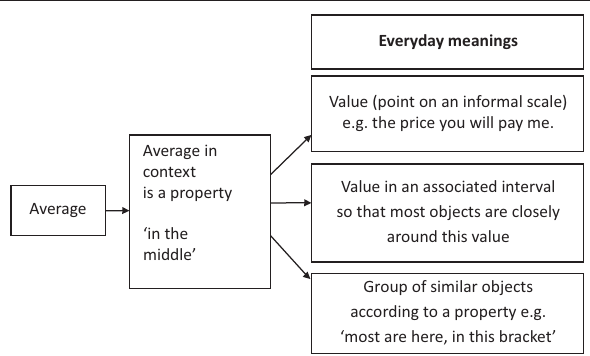
FIGURE 2: Three narratives about the mean as the average in everyday